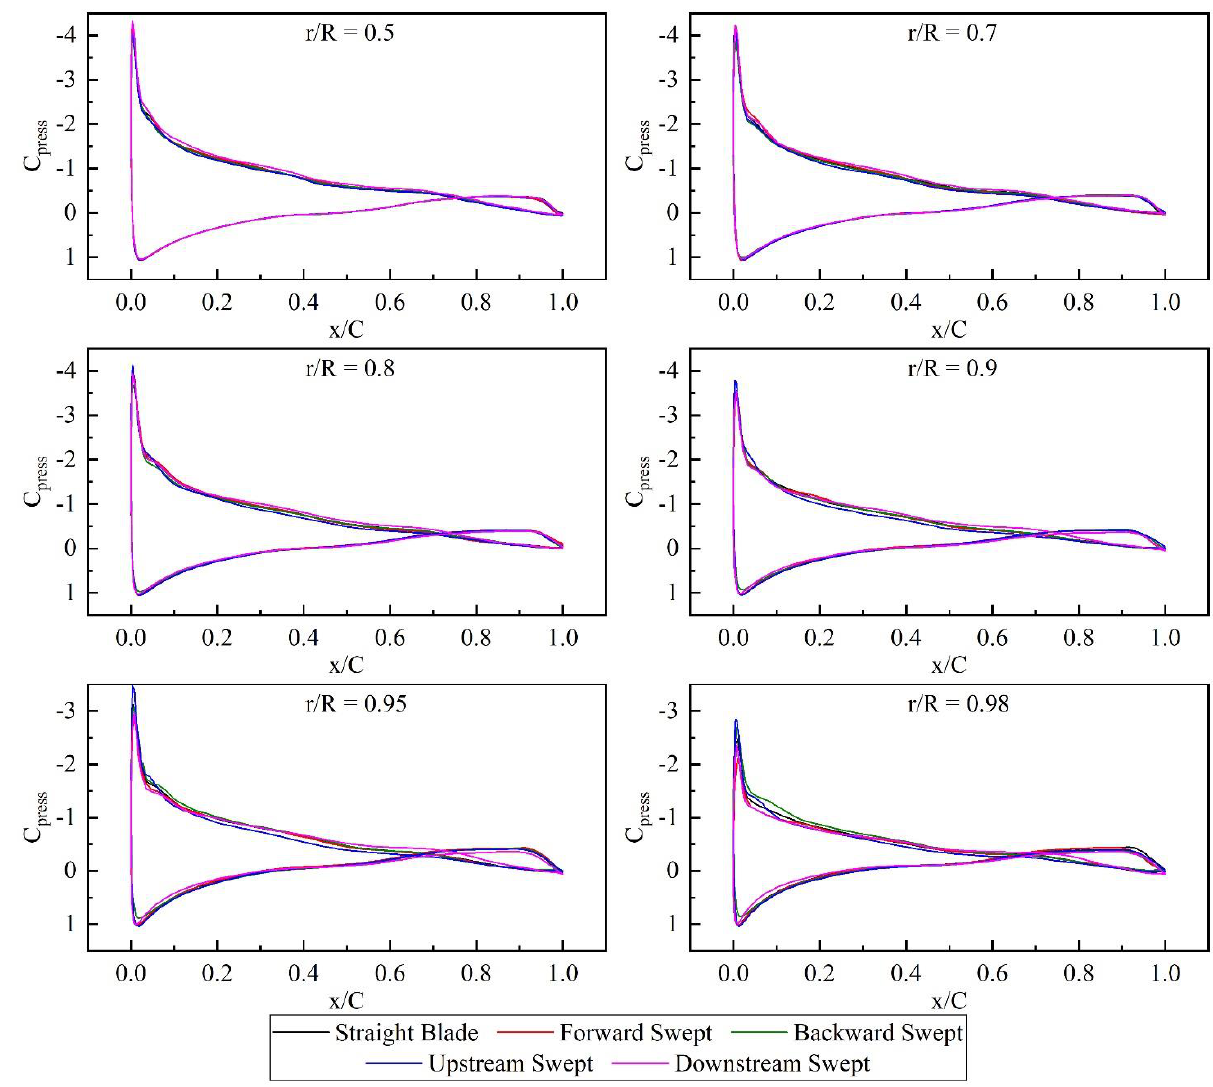
Figure 13. Pressure Coefficient distributions on six blade sections at TSR = 6.